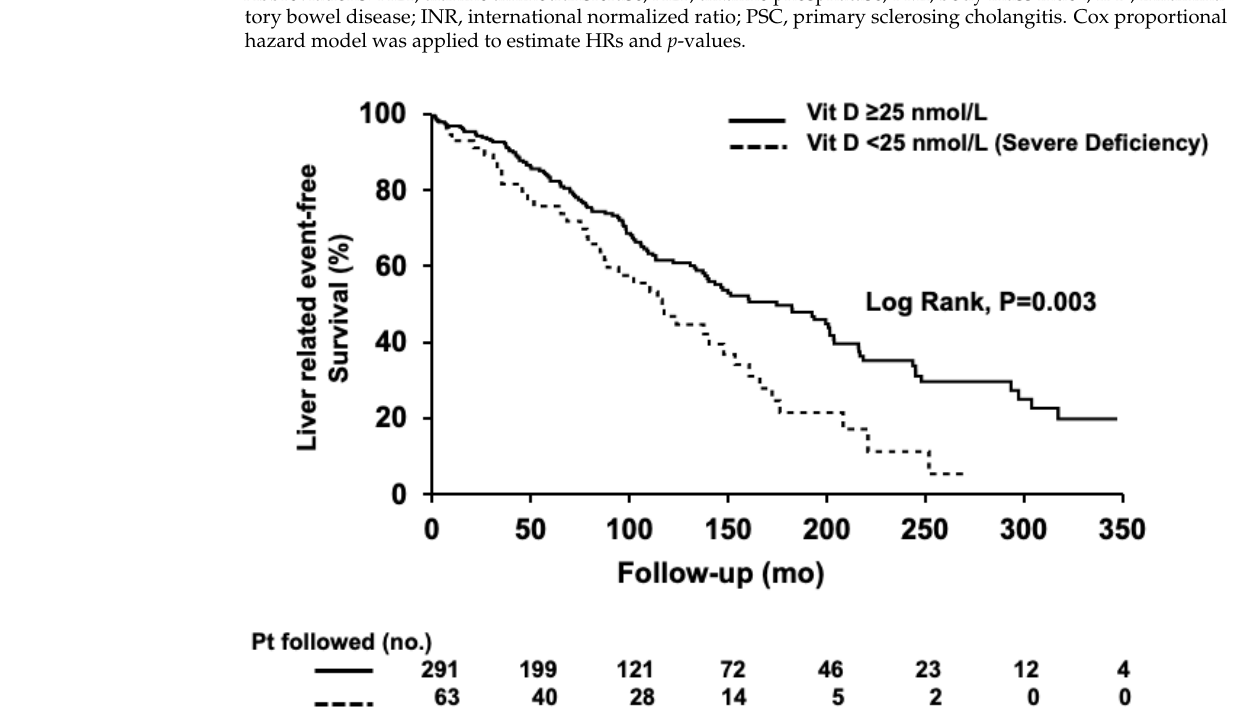
Table 4. Association between Longitudinal Severe Vitamin D deficiency and Liver-Related Events (Mortality and Transplantation).